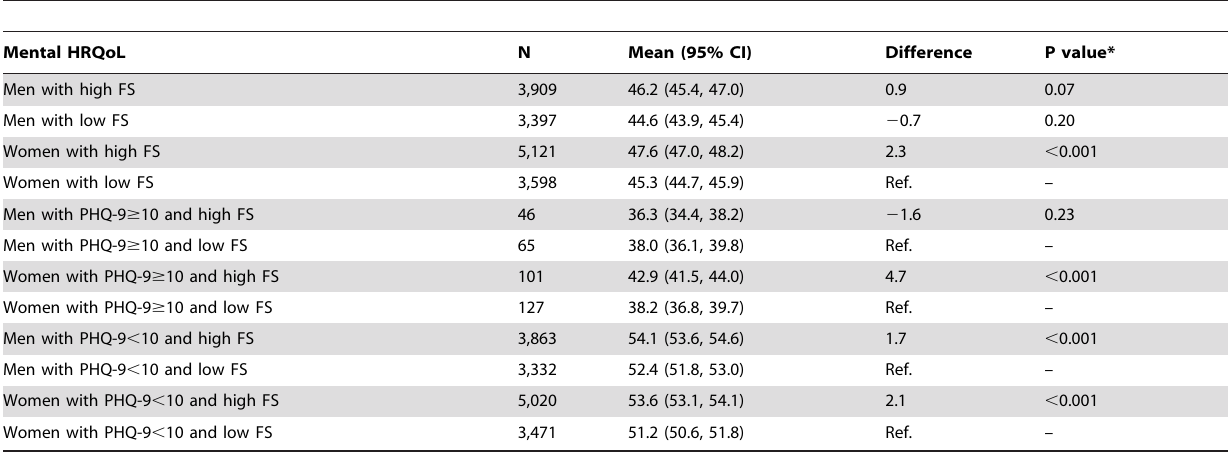
Table 4. Mean (95% confidence interval, CI) and its difference of mental health related quality of life stratified by sex, satisfaction with family support (FS) and depressive symptoms.